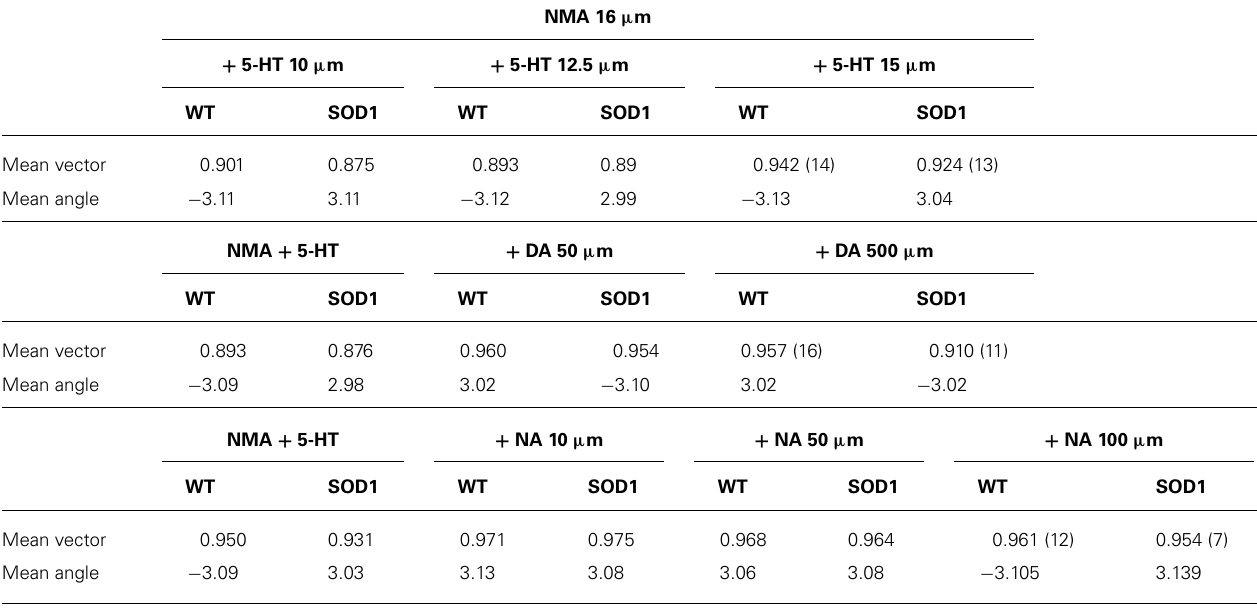
Table 2 | Circular statistics of the phase relationships between right and left L2s in the presence of the different monaminergic